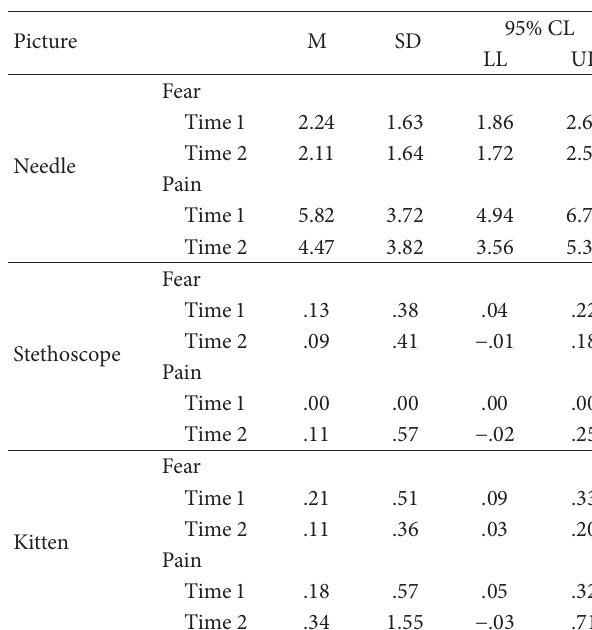
coping strategies. Children reported a higher frequency of intervention-taught coping strategies at Time 2 (M =